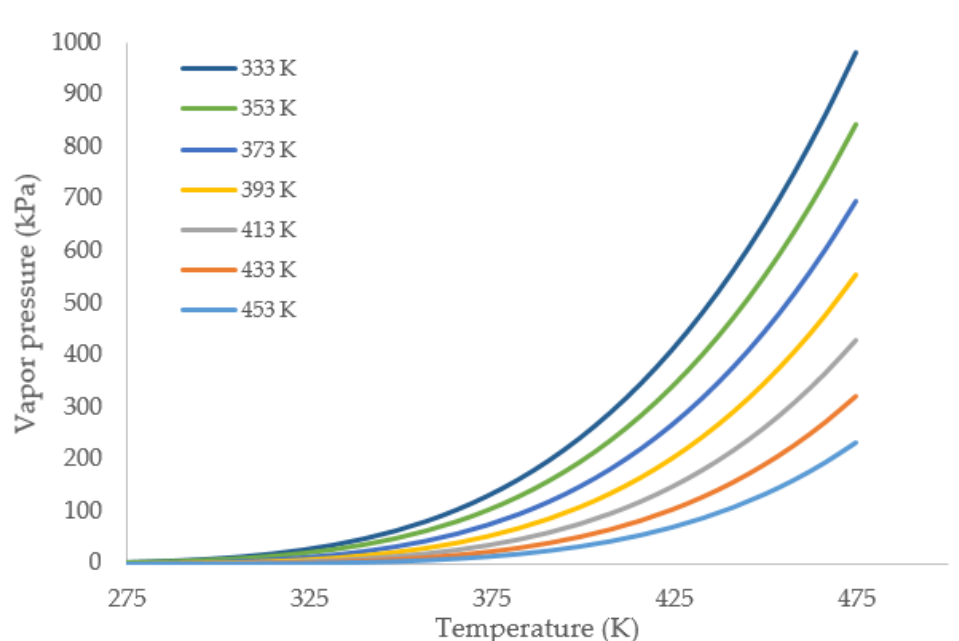
Figure 4. Predicted vapor pressure of gasoline fractions with varying normal boiling points. The values in legends are temperature in